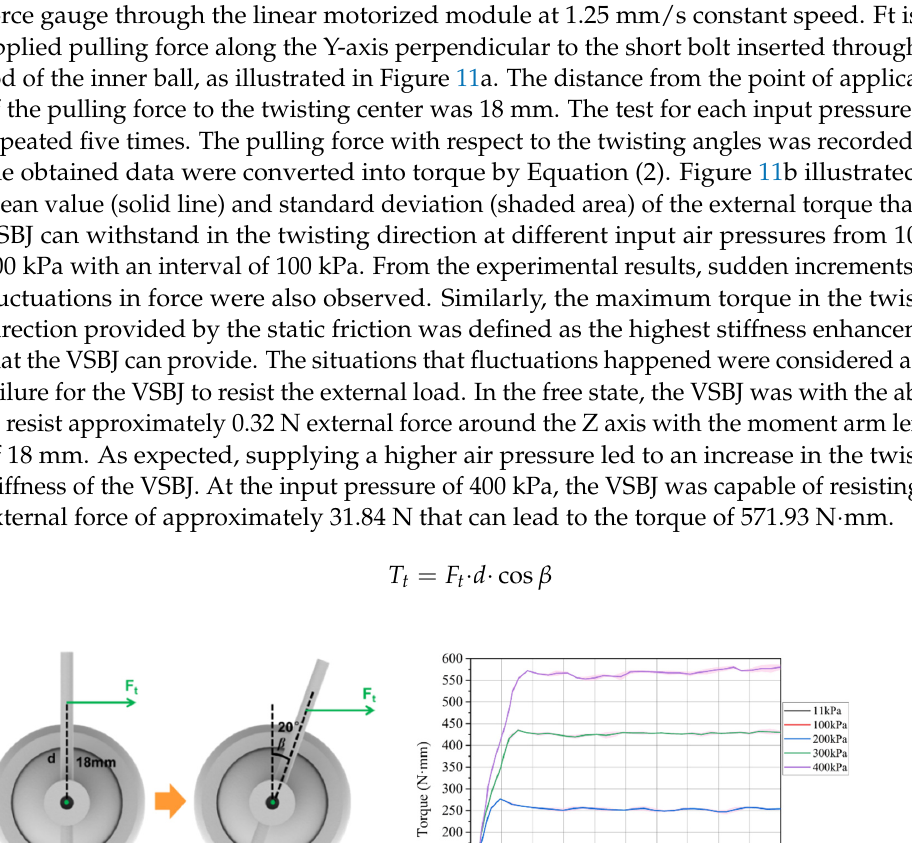
Figure 10. The experimental setup for measuring the twisting stiffness of the VSBJ.